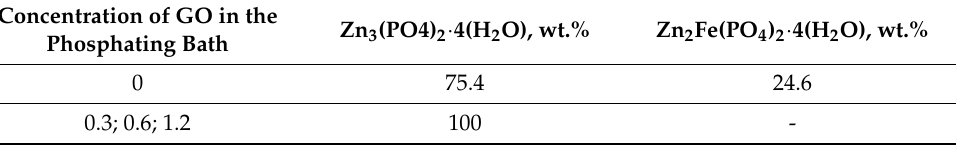
Figure 4. XRD patterns of phosphate coatings obtained from phosphating bath with different content of GO (top down): without adding GO to the phosphating solution (black line); with the addition of 0.3 g/L GO (red line); with the addition of 0.6 g/L GO (blue line); and with the addition of 1.2 g/L GO (green line). Table 4. Phase composition of the phosphate